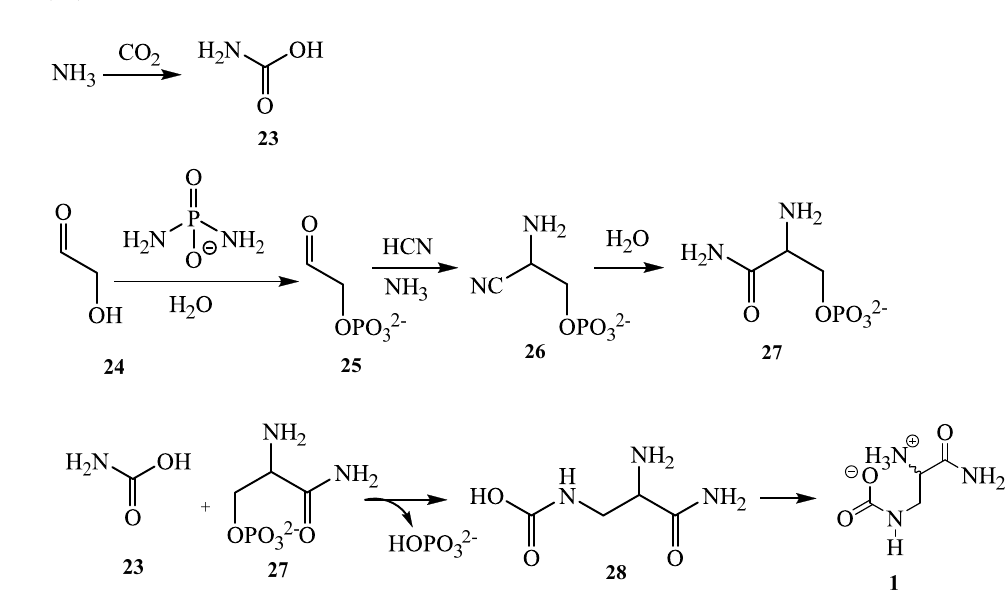
Table 2. Minimum Inhibitory Concentration (MIC), Minimum Bactericidal Concentration (MBC) and Minimal Fungicidal Concentration (MFC) values (in µ g/mL) of extracts, fractions, and compounds from Albizia lebbeck